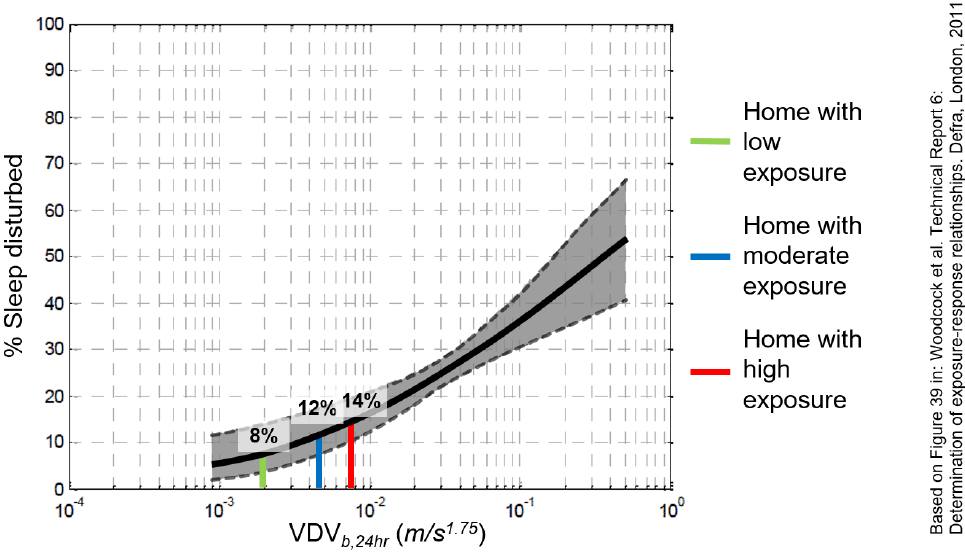
Figure A2. Exposure-response relationship showing the percentage of people reporting sleep disturbance for a given vibration exposure. Using the converted exposure data from the Graz immission survey (slow weighting). Table A1. Vibration exposure of analyzed tramways by tram type and time weighting.